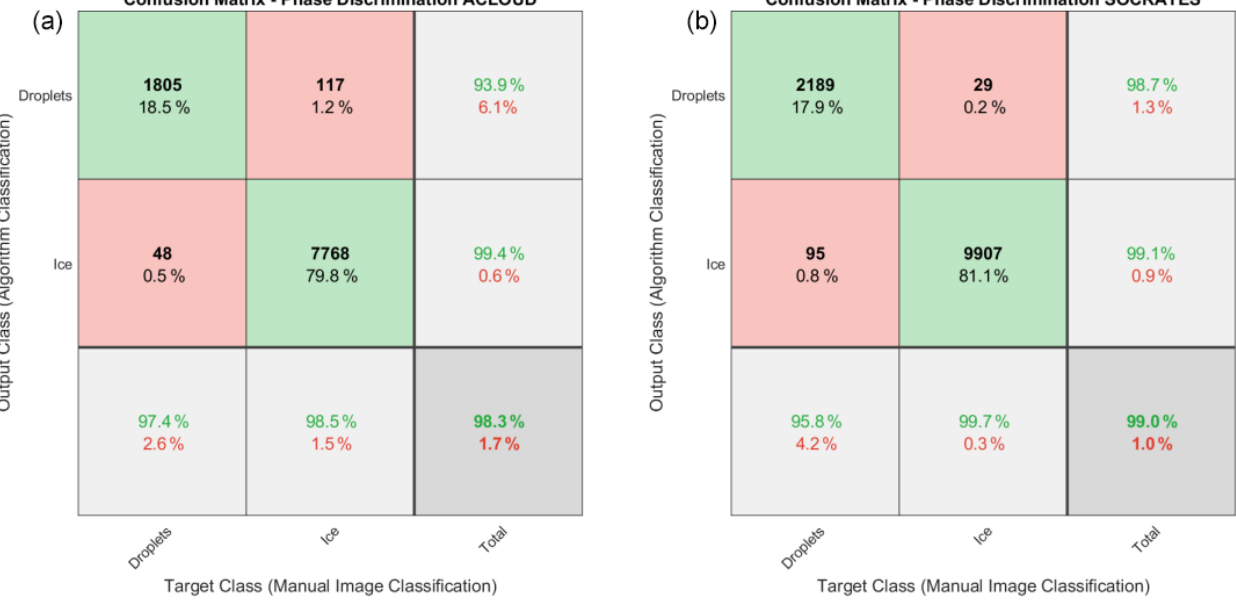
Figure 7. Confusion matrices that visualize the classification accuracy of the ice discrimination algorithm. The discrimination algorithm was applied to all manually classified particles from both the ACLOUD (a) and SOCRATES (b) data sets. In both cases the combined probability P combined from the ACLOUD calibration was used to calculate the classification probability of each individual particle.